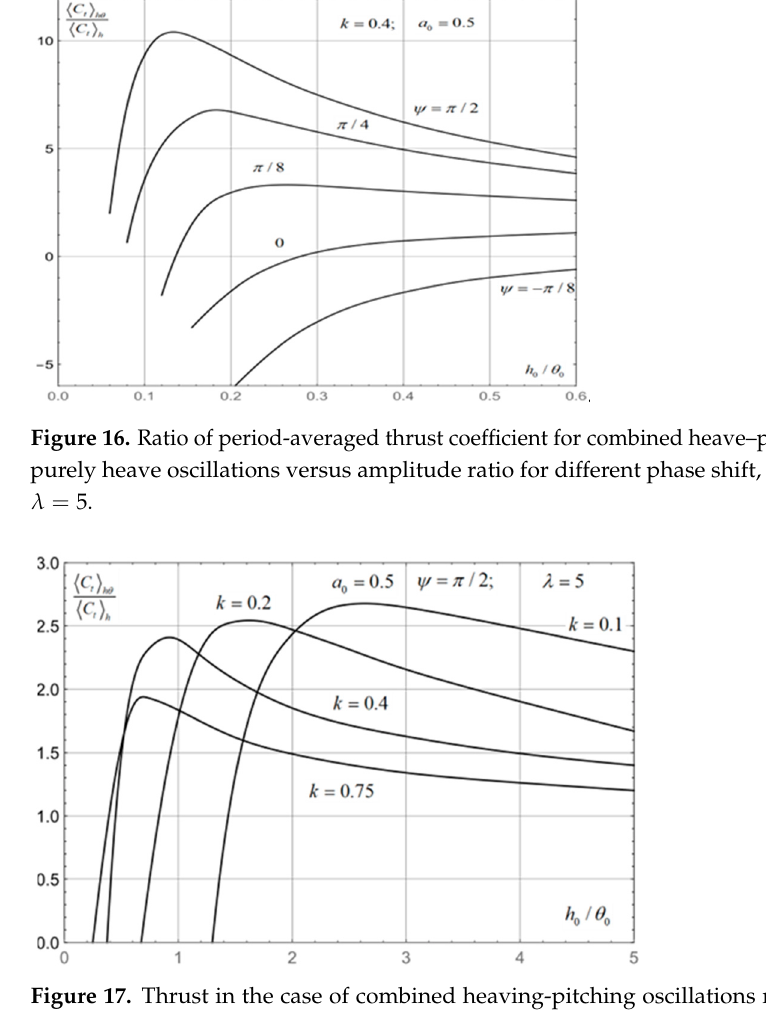
Figure 15. For combined heaving–pitching oscillations versus amplitude ratio and different . λ